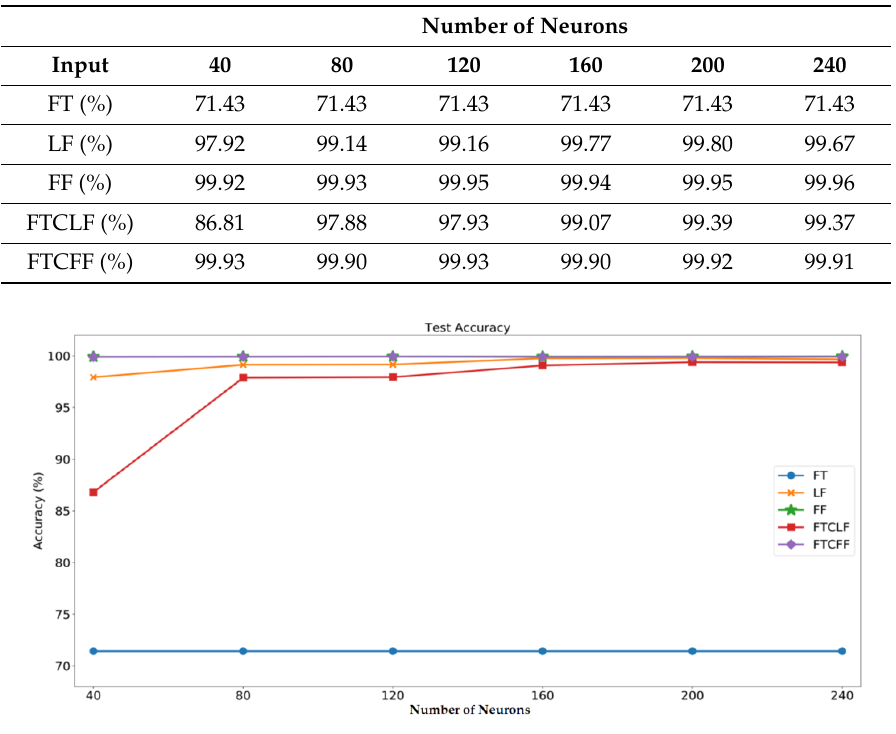
Figure 17. Accuracy results of the test set.